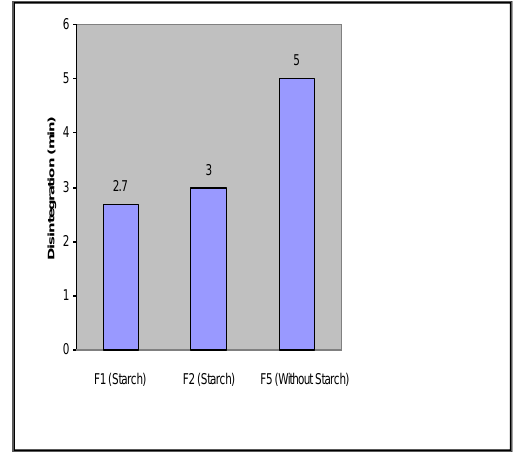
6: Effect of excipient type on disintegration time of formula F1 (Starch), F2 (Starch) and F5 (without Starch) Bisoprolol tablets